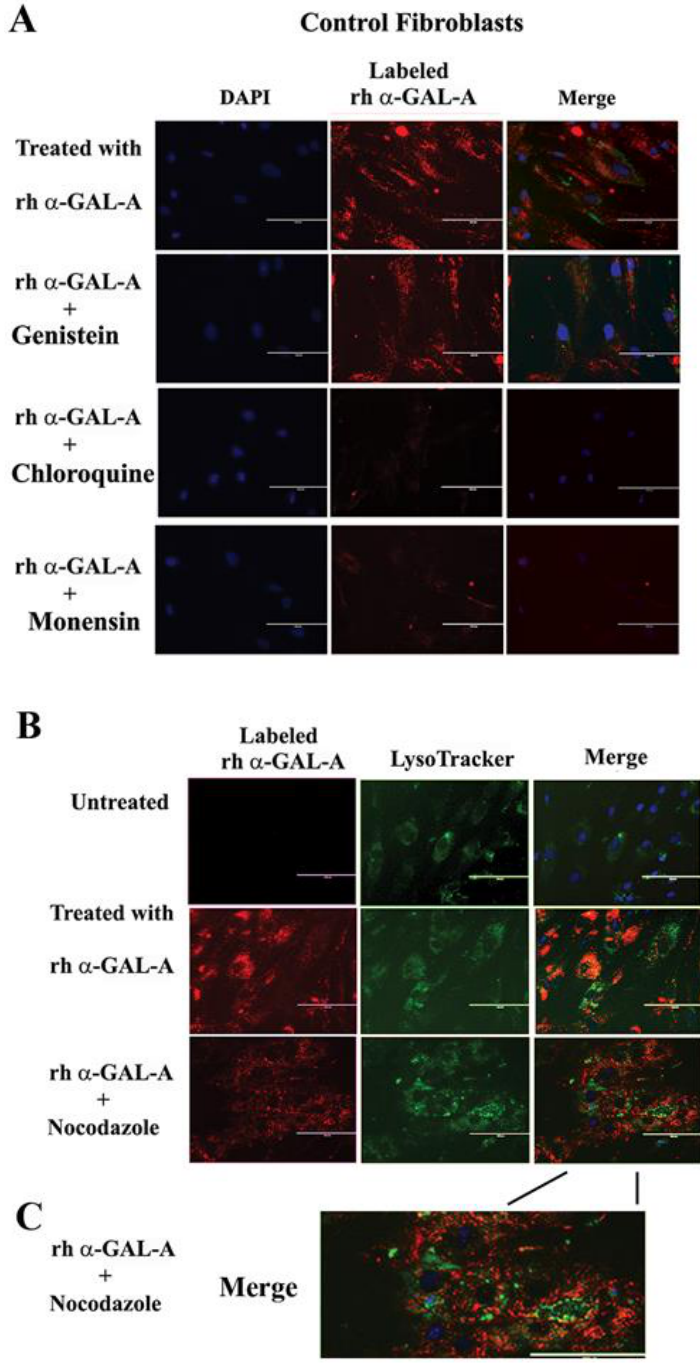
Figure 5. The trafficking of the recombinant enzyme is inhibited in the presence of chloroquine, monensin, and nocodazole. Control fibroblasts were co-treated with fluorescence-labeled rh-α-Gal-A and inhibitors genistein, chloroquine, monensin, and nocodazole. ( A ) Immunofluorescence images of control fibroblasts treated with fluorescence-labeled rh-α-Gal-A (red). Bars: 200 μm. ( B ) Immunofluorescence images of control fibroblasts treated with fluorescence-labeled rh-α-Gal-A (red) and stained with LysoTracker (green). Bars: 200 μm. ( C ). The magnified merge image of cells with Alexa-Fluor-α-Gal-A (red) and LysoTracker (green) after nocodazole treatment.